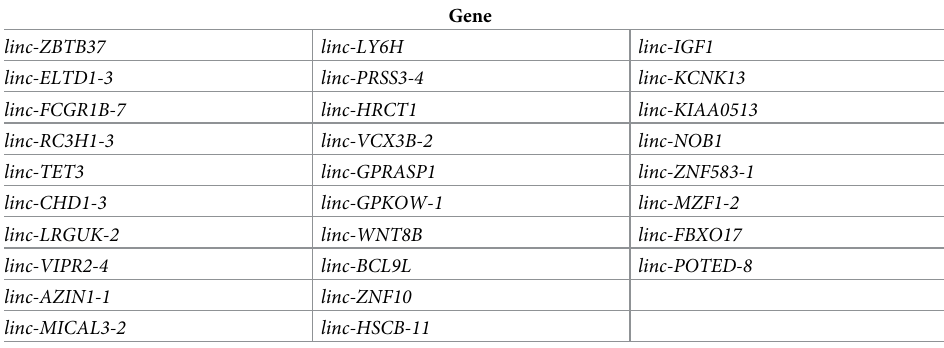
Table 6. List of differentially expressed non-coding